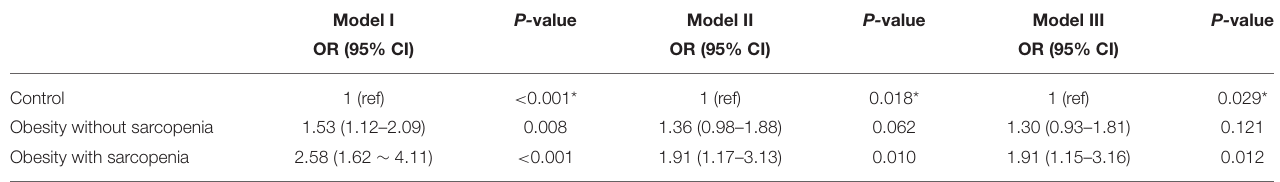
TABLE 5 | Multivariate analyses of the risk for coronary artery calcification according to obesity with or without